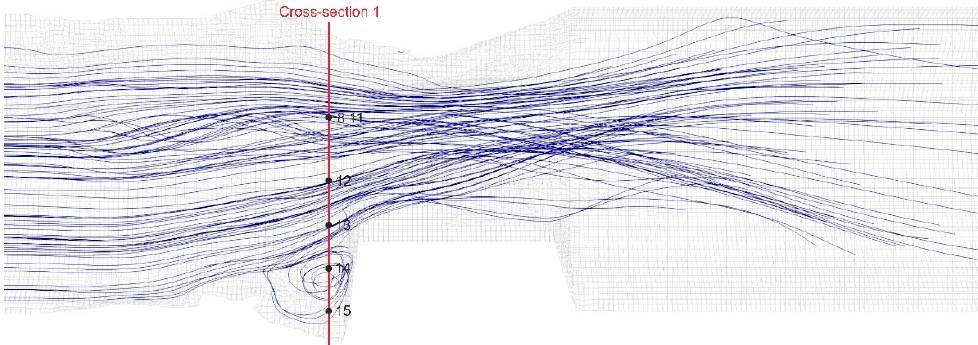
Figure 9. Simulated streamlines at cross-section 1 (flow is from left to right). The eddy circulation is clearly visible on the right side of the stream.